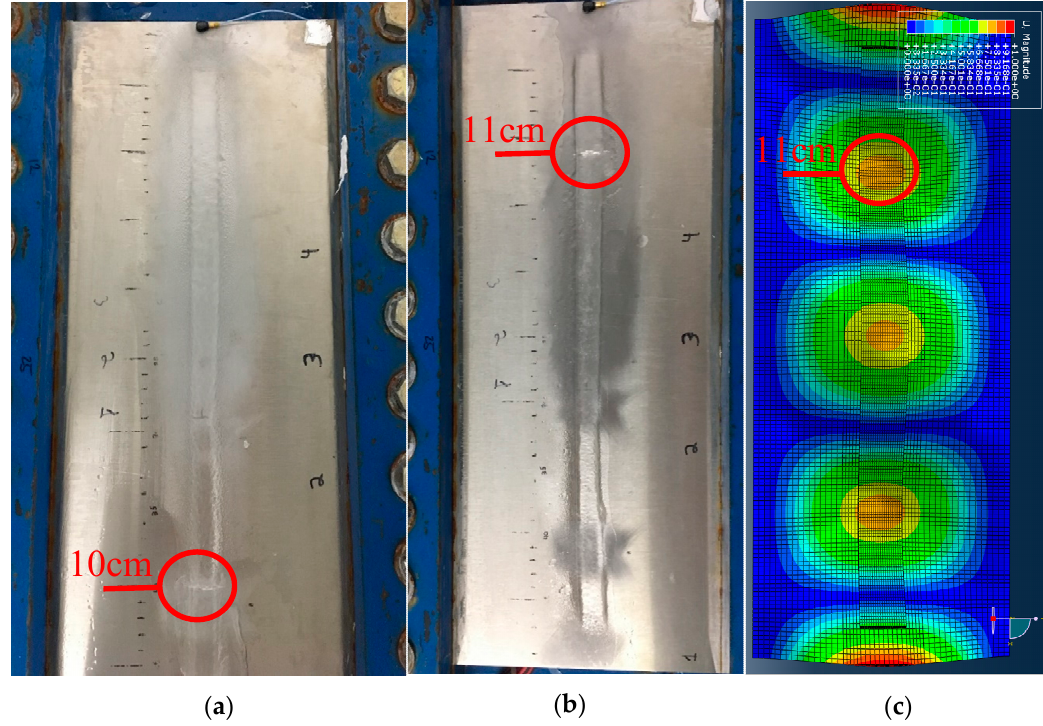
Figure 6. Crack at 300 Vpp at 10 cm from edge for repetition 1 ( a ) and at 370 Vpp at 11 cm from edge for repetition 2 ( b ) and modal shape predicted numerically ( c ).